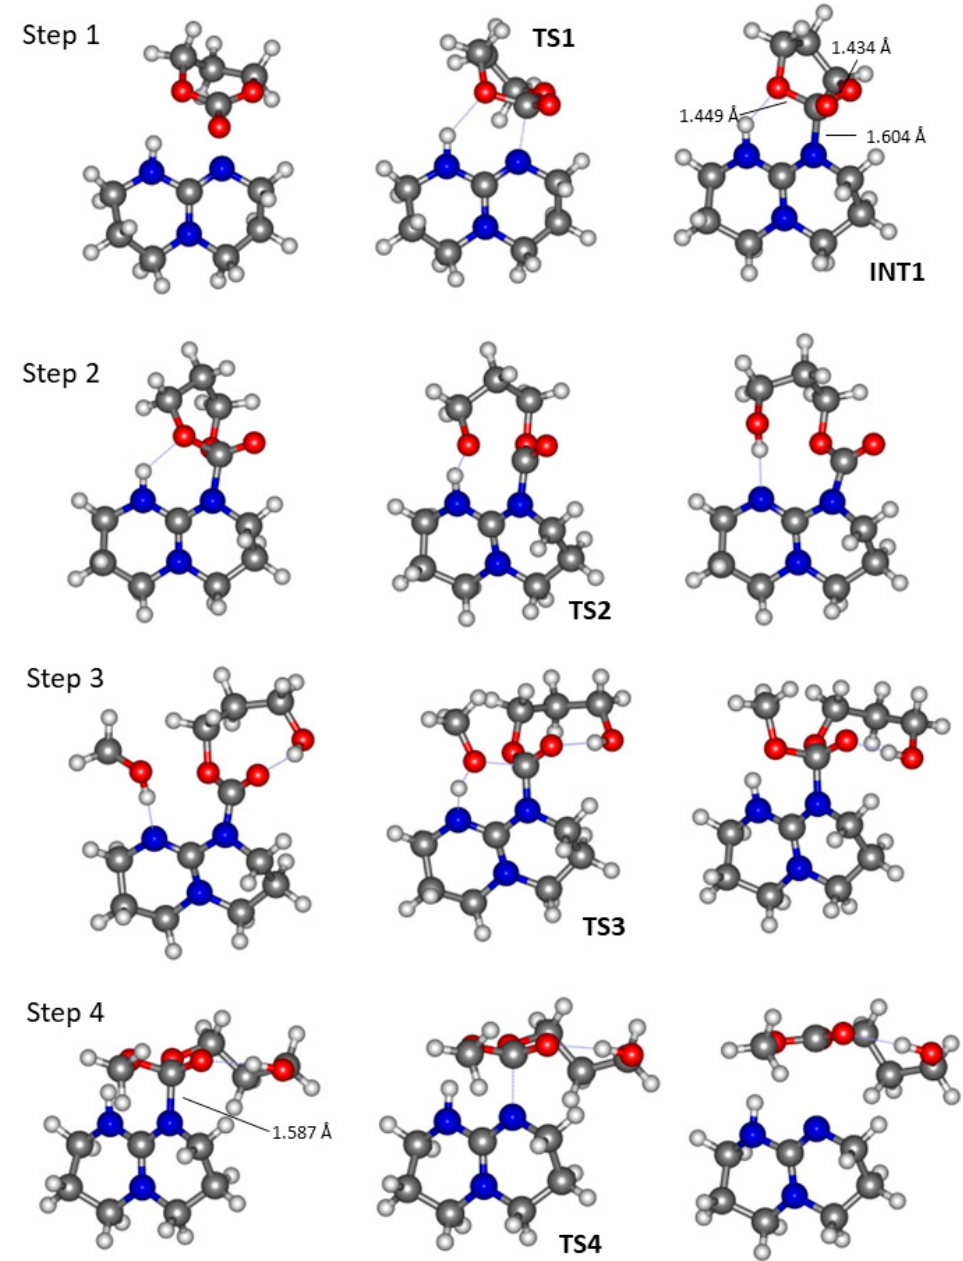
Figure 2. Optimized geometry structures of the species involved in the nucleophilic mechanism for the TBD-catalysed ring-opening polymerization of TMC. Colour code: C grey, O red, N blue and H white.